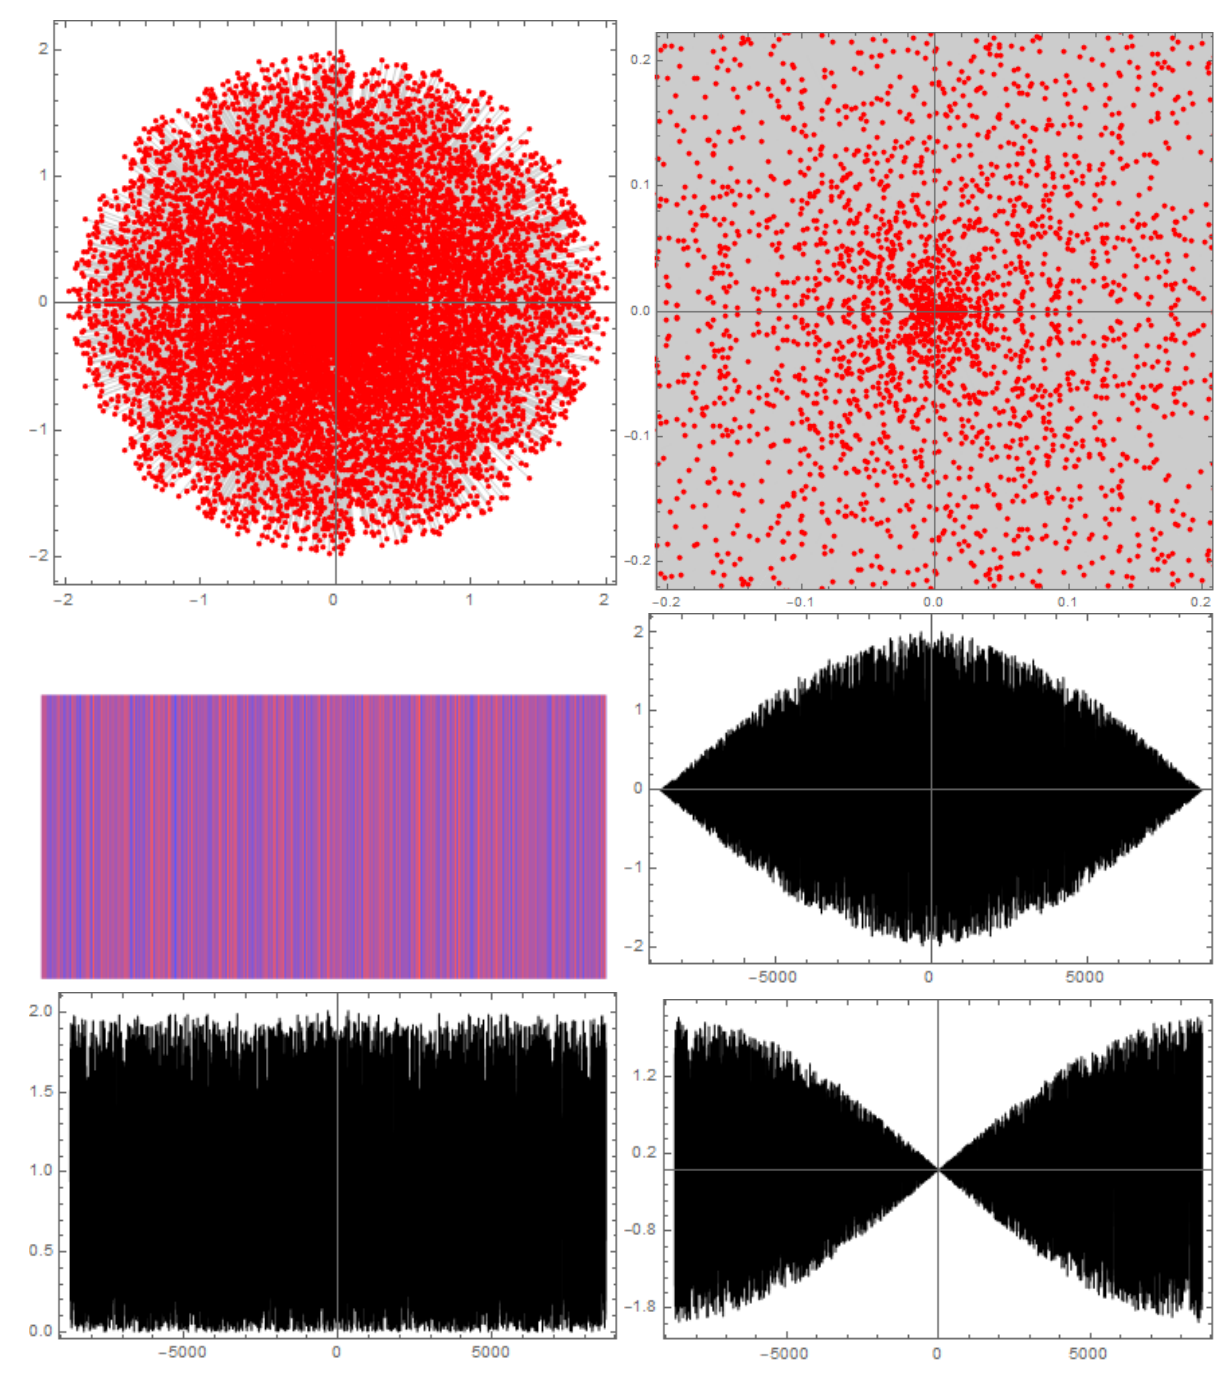
Figure 7. Fourier analysis of the perfect square and nonsquare profiles for the case of m = 17,389 (the 2000th) prime. The top panels show the scatter plot of the discrete Fourier transform of T 17,389 (full plot, left panel, zoomed in, right panel). The ordinate is the imaginary value, and the abscissa is the real value. The middle left panel shows the block-color plot of the perfect squares (red) and nonsquares (blue) in T 17,389 . The bottom left panel shows the absolute value of the discrete Fourier transform. The middle and bottom right panels show the real and imaginary parts of the the discrete Fourier transform, respectively. Fourier transforms were performed using M ATHEMATICA